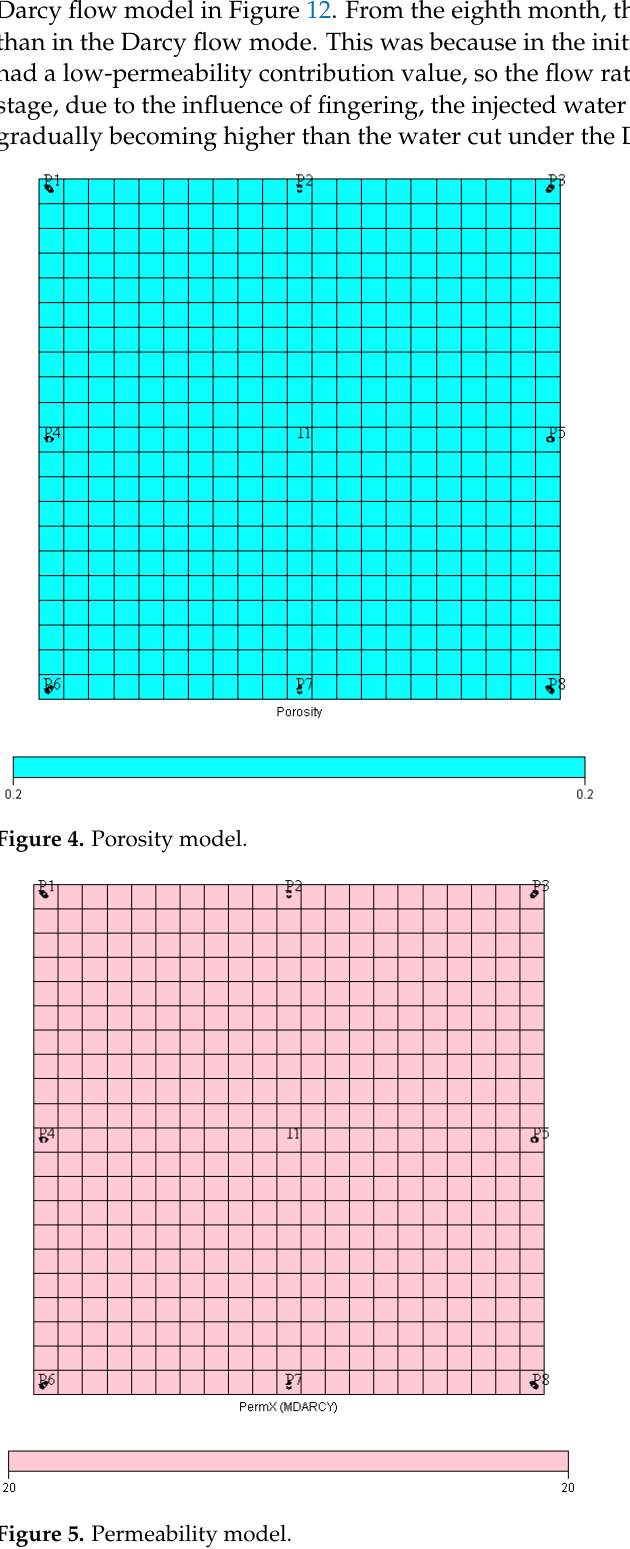
Figure 5. Permeability model.